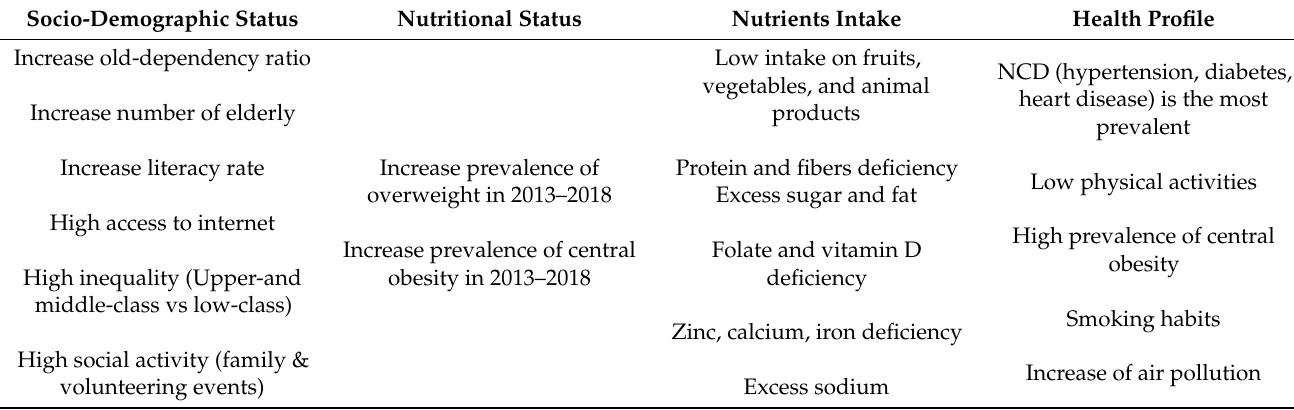
Table 1. Summary of the key issues on socio-demographic status, nutritional status, nutrients intake and health profile of the adult population in